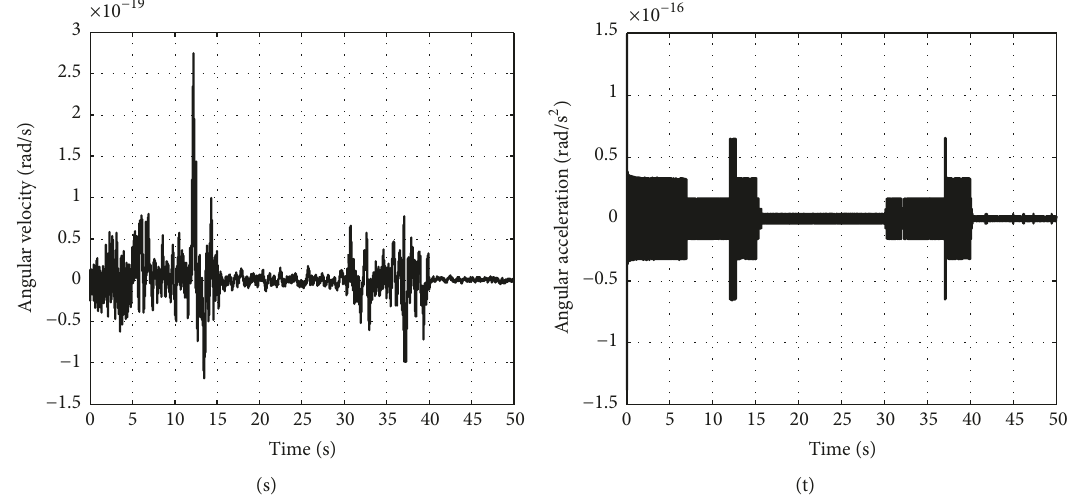
Figure 16: Simulation results of the EV driven under different road